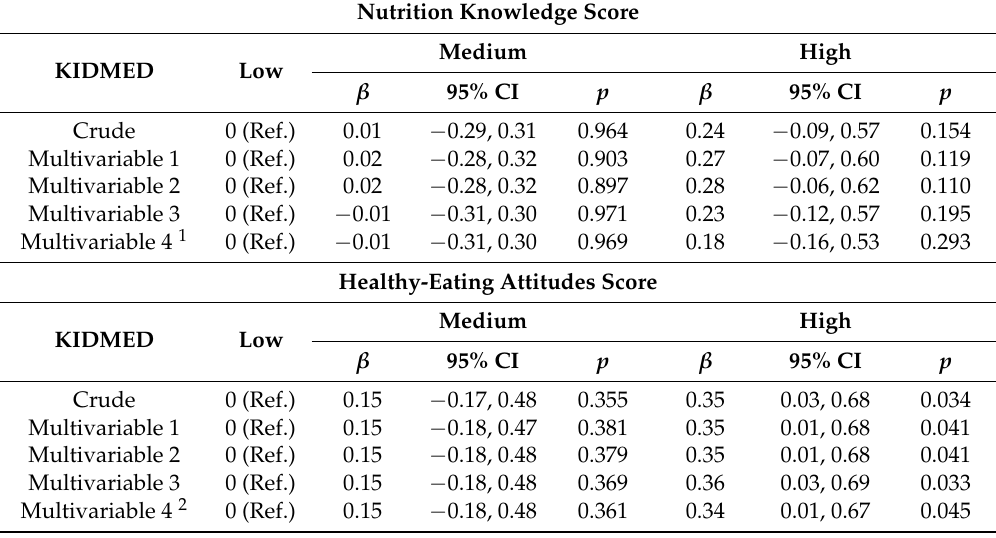
Table 4. Multivariate regression coefficients ( β coefficient and 95% confidence intervals) for the association of parental nutrition knowledge and healthy-eating attitudes score with children’s score in the KIDMED test.